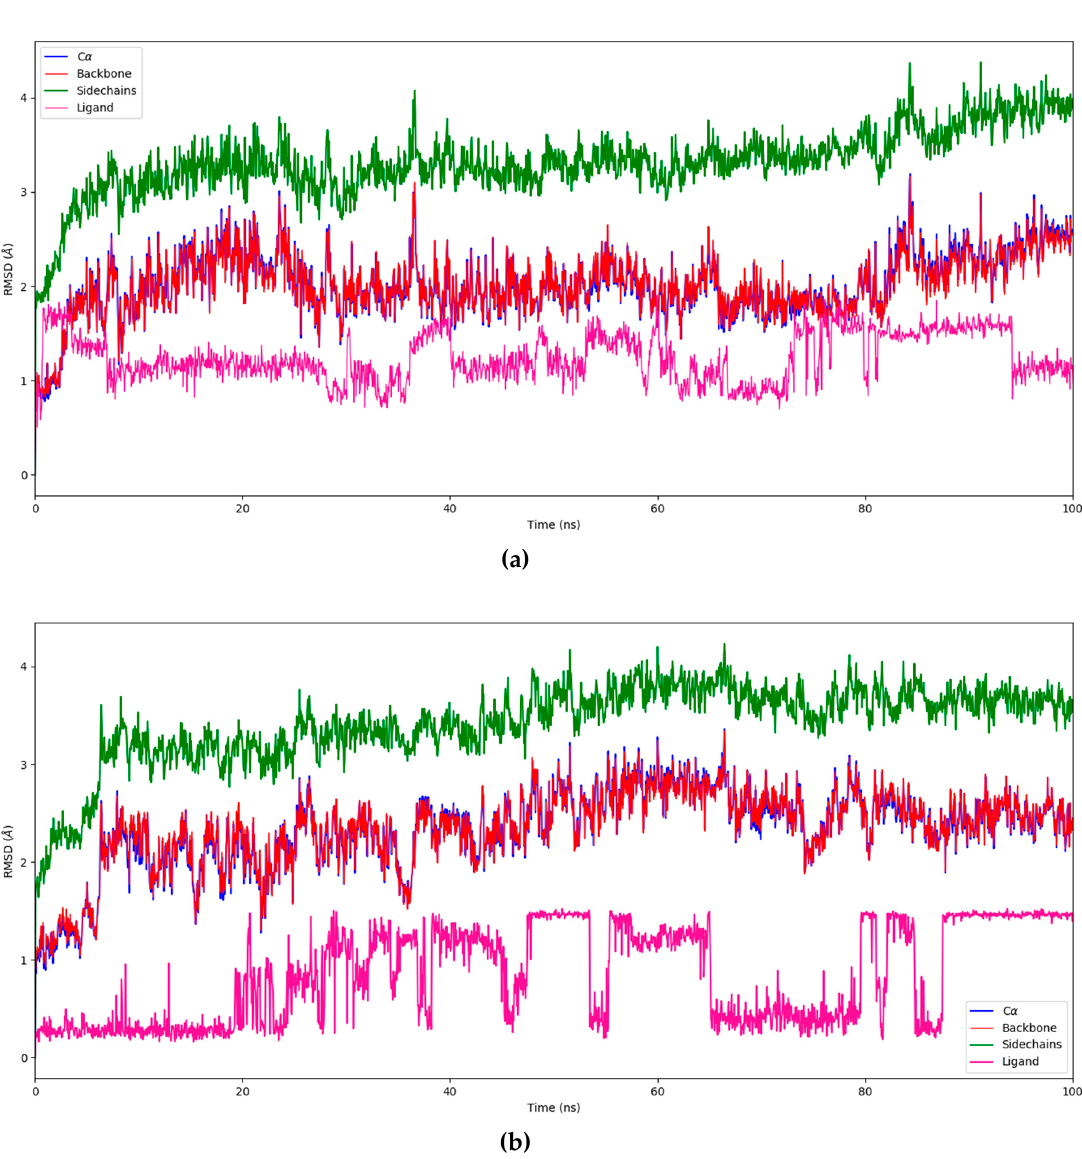
Figure 5. Root-mean-square deviation (RMSD) values for the protein backbone, alpha carbons, side chains, and ligand. ( a ) Amentoflavone; ( b ) Fisetin.